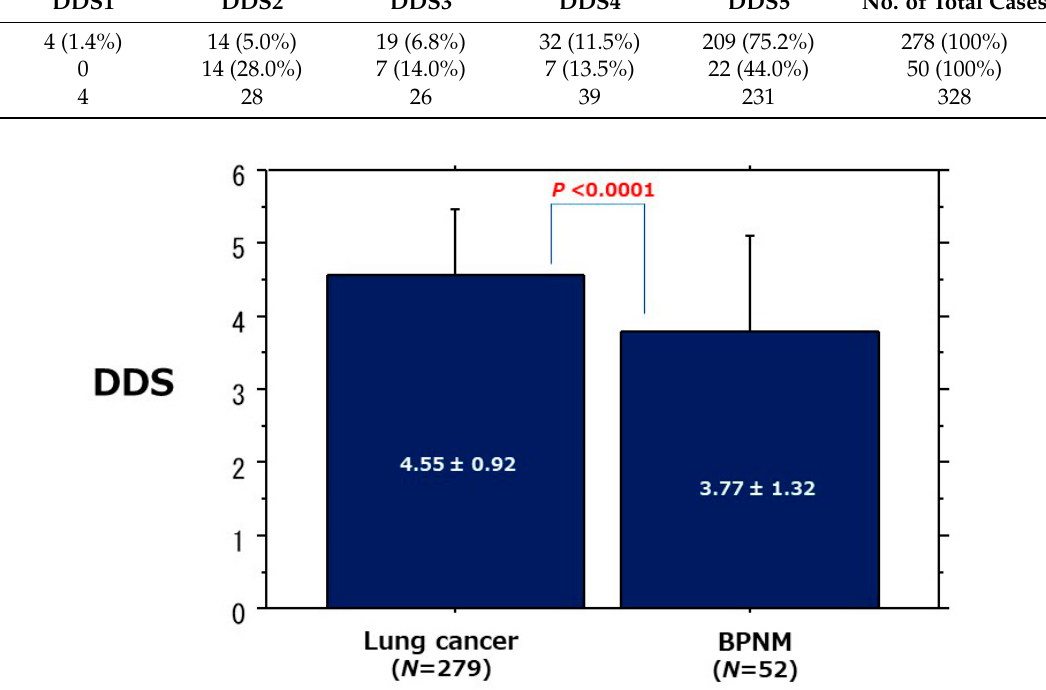
Figure 1. Comparison of DDS between lung cancer and BPNM. The mean DDS (4.55 ± 0.92) of lung cancer was significantly higher than that (3.77 ± 1.32) of BPNM ( p < 0.0001). 3.2. Radiologic Presentations of CT, FDG-PET/CT, DDS of DWI, ADC Map and T2WI in PNMs According to the DDSs, malignant/benign PNMs, chest CT, FDG-PET/CT, DWI, ADC map, and T2WI are presented in Figures 2–6.